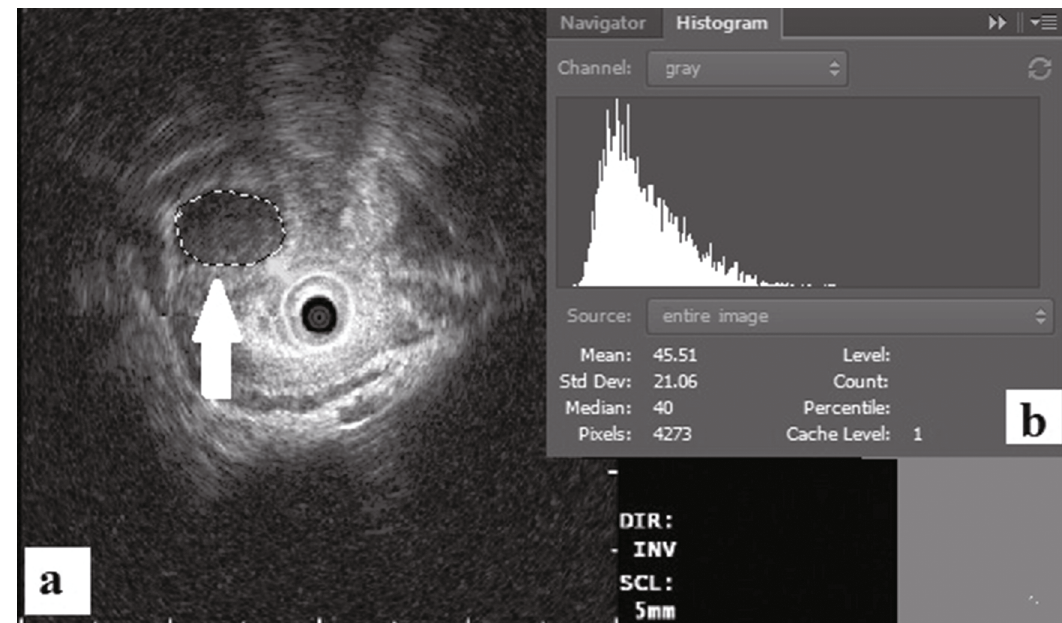
Figure 1: Endoscopic ultrasound combined with grayscale histogram (a,